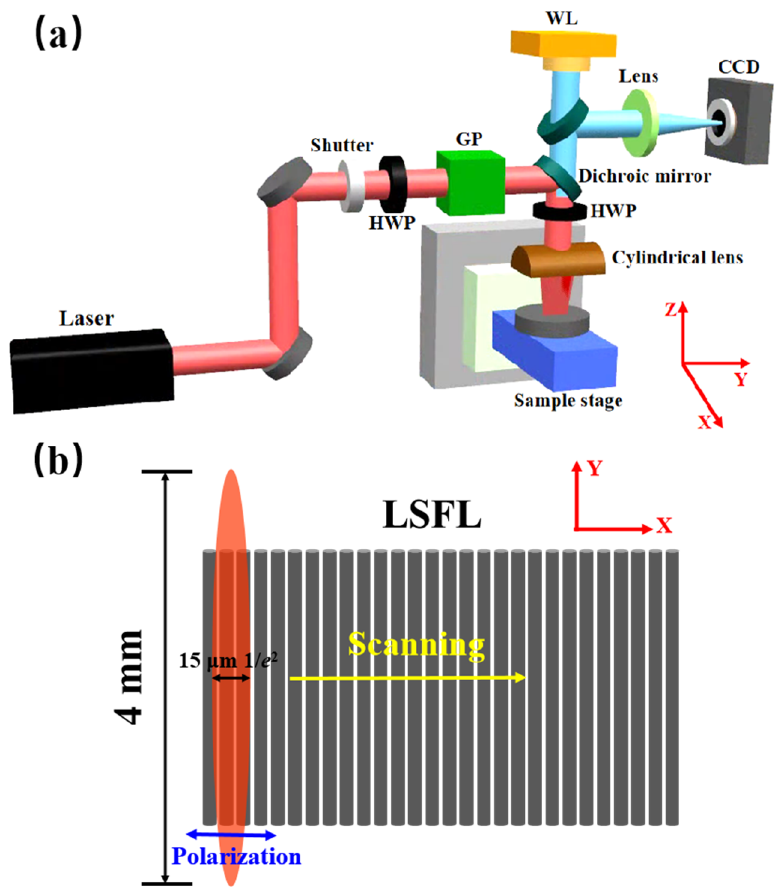
Figure 1. ( a ) Schematic of the laser direct writing setup. HWP is a half-wave plate, GP is a Glan prism and WL is a white light source. ( b ) Schematic of the laser polarization, focal spot and scanning direction. A glass substrate with a diameter of 30 mm coated with ITO film of thickness 175 ±